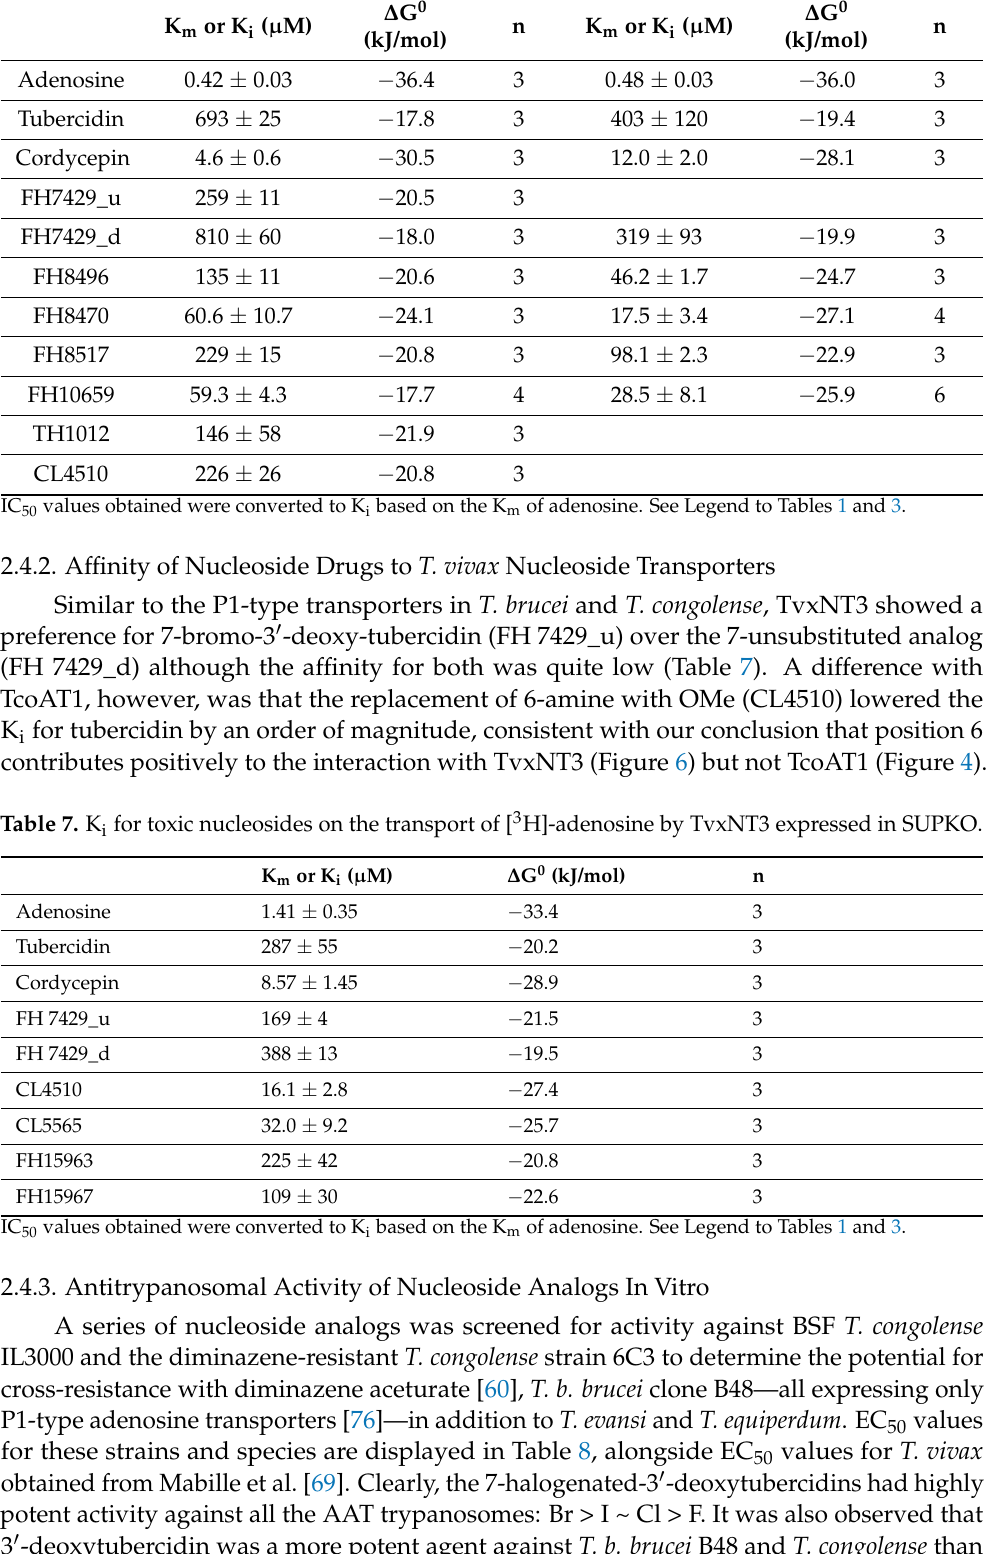
Table 6. K m or K i , ∆ G 0 and δ ( ∆ G 0 ) for toxic nucleosides on the transport of [ 3 H]-adenosine by TcoAT1 expressed in L. mexicana SUPKO and by T. congolense IL3000 bloodstream forms. TcoAT1 in L. mexicana SUPKO